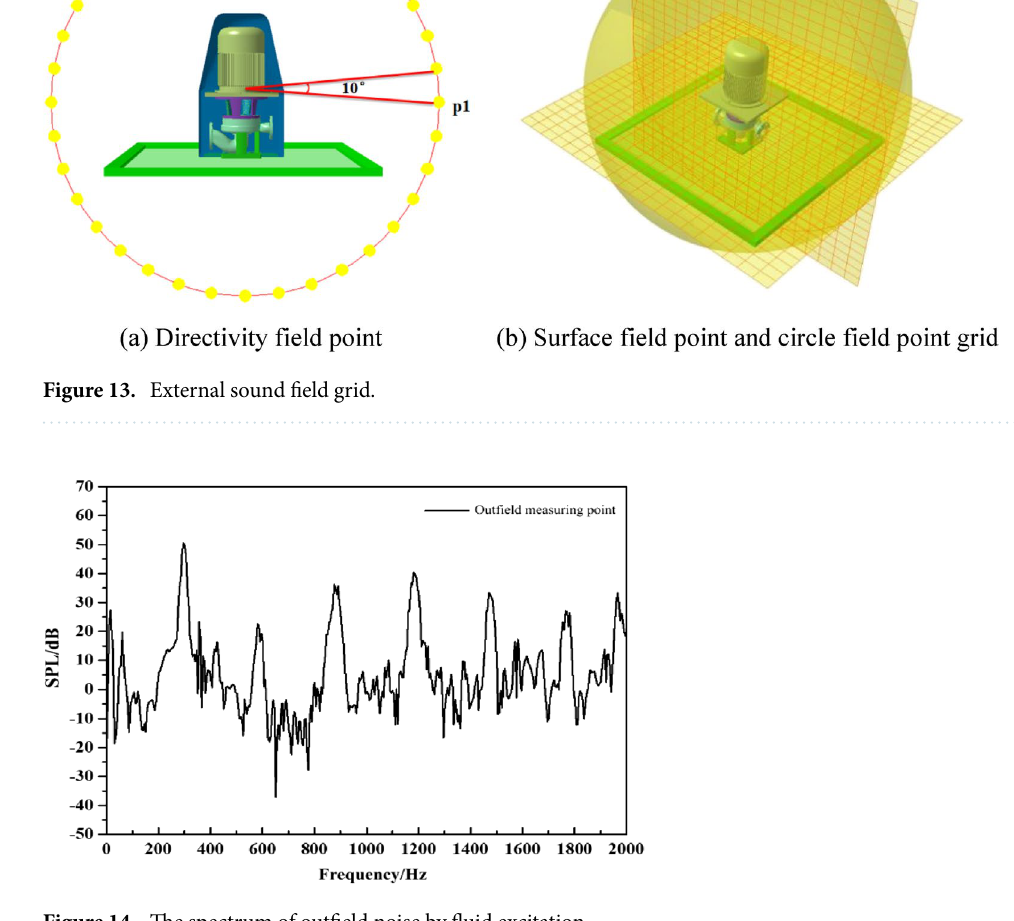
Figure 14. The spectrum of outfield noise by fluid